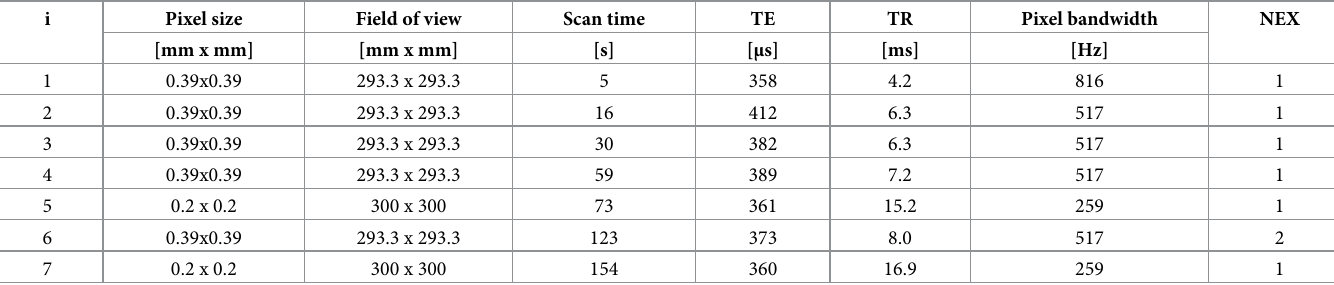
Table 1. MCP acquisition details for images